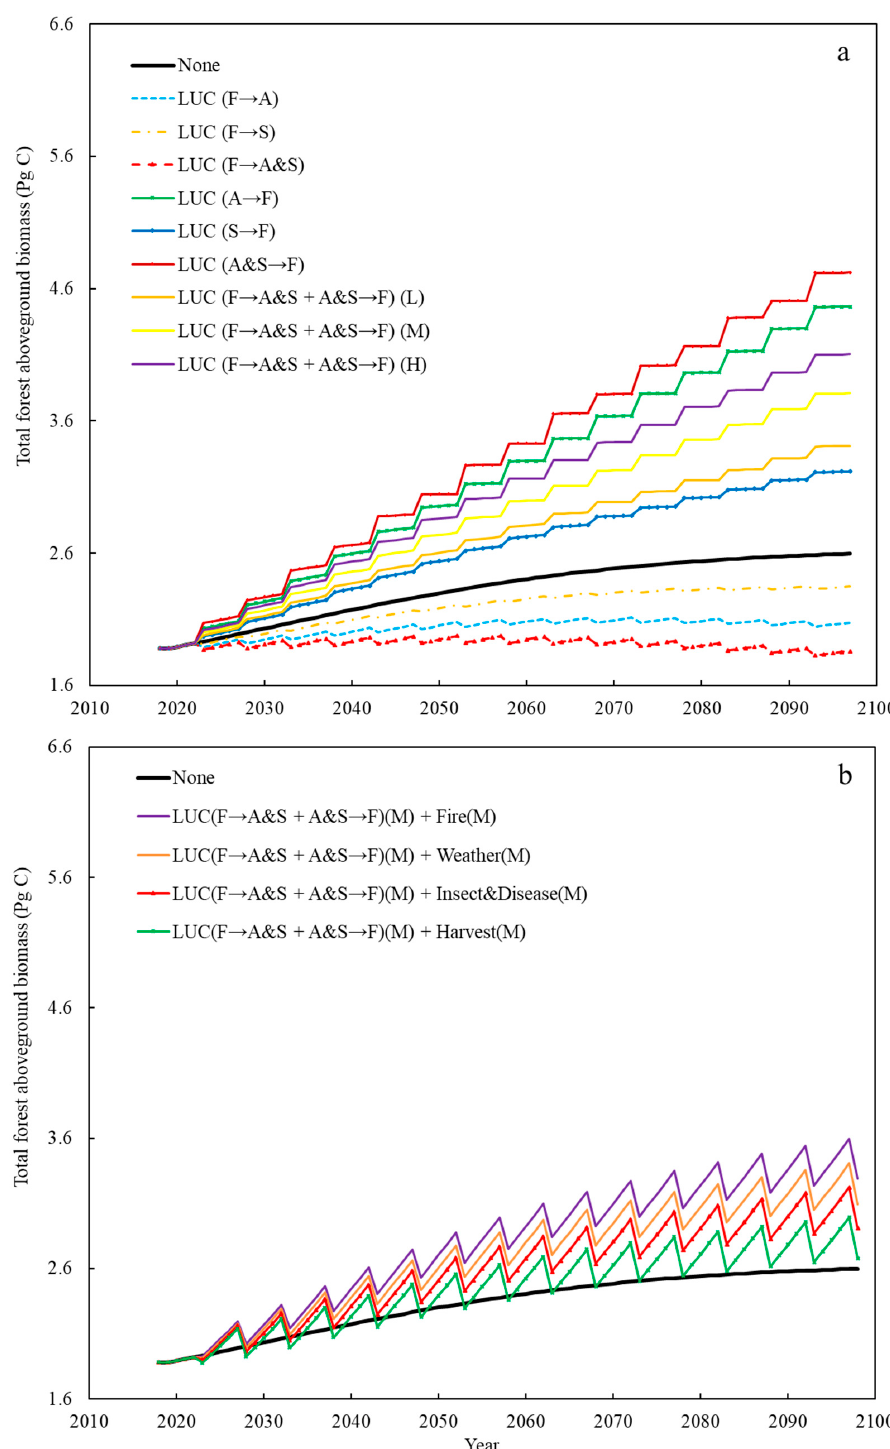
Figure 6. Predicted total forest aboveground biomass (Pg C) from 2018 to 2098 under land use change—LUC with low (L), medium (M), and high (H) severity ( a ) and medium LUC + disturbances ( b ) in the Northern US. Land use change (forest [F] → agriculture and settlements / other [A&S], and A&S → F) includes specific changes from F → A, F → S, F → A&S, A → F, S → F, and A&S → F. Disturbances include fire, weather, insect and disease, and harvest. None and validation represent forests that naturally grow without considering LUC and